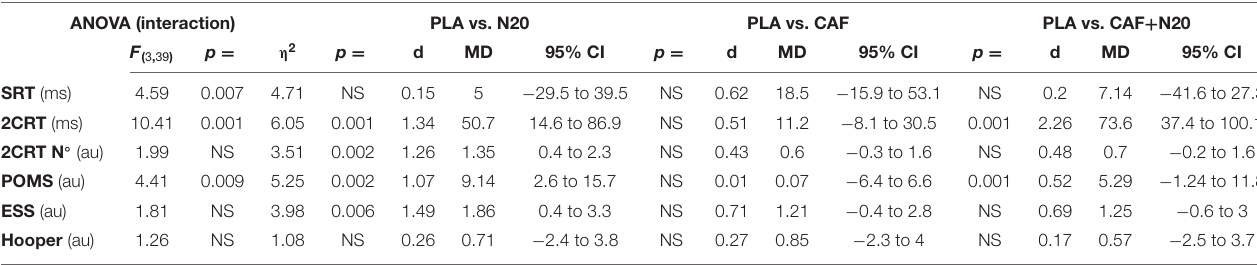
TABLE 1B | Simple and two-choice reaction time and self-administered questionnaires’ ANOVA output and pairwise comparison with PLA after normal sleep night ( study 2 ) . ANOVA (interaction) PLA vs. N20 PLA vs.